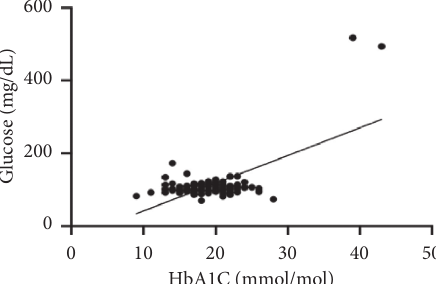
Figure 2: Relation between glucose and HbA1c ( r � 0.386; p � 0 . 0001).